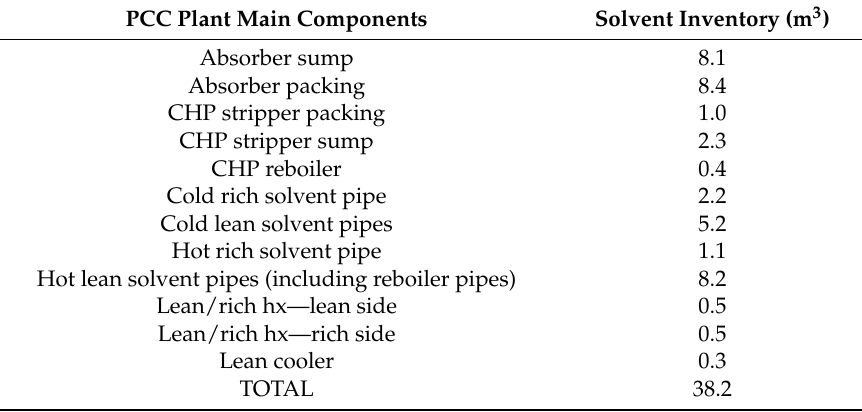
Table 2. Averaged values of total solvent inventory and its distribution within the main components of the TCM